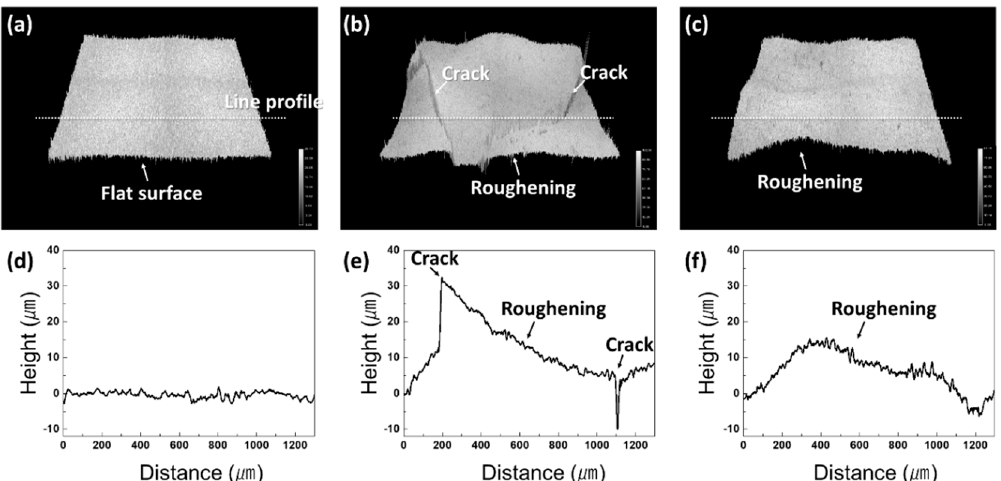
Figure 9. Laser surface observation of the Ni–P layer on DBA substrates with Si 3 N 4 at the initial state ( a ) and after 1000 cycles ( b , c ). Local area with cracked ( b ) and roughened ( c ) area, and its roughness profile ( d – f ) measured by a line profile corresponding to ( a – c ), respectively.